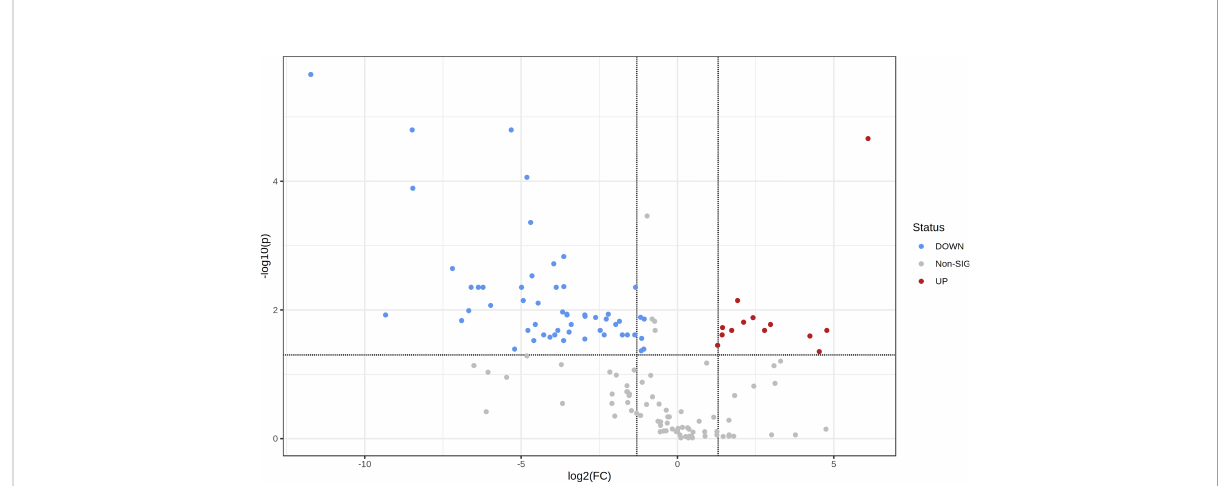
FIGURE 5 Volcano plot showing the metabolic features relative content in fresh leaf extracts (FLE) and dried leaf extracts (DLE). Higher content in young trees (YT) is given by FC < 2 and p < 0.05; higher content in mature trees (MT) is given by FC > 2 and p <